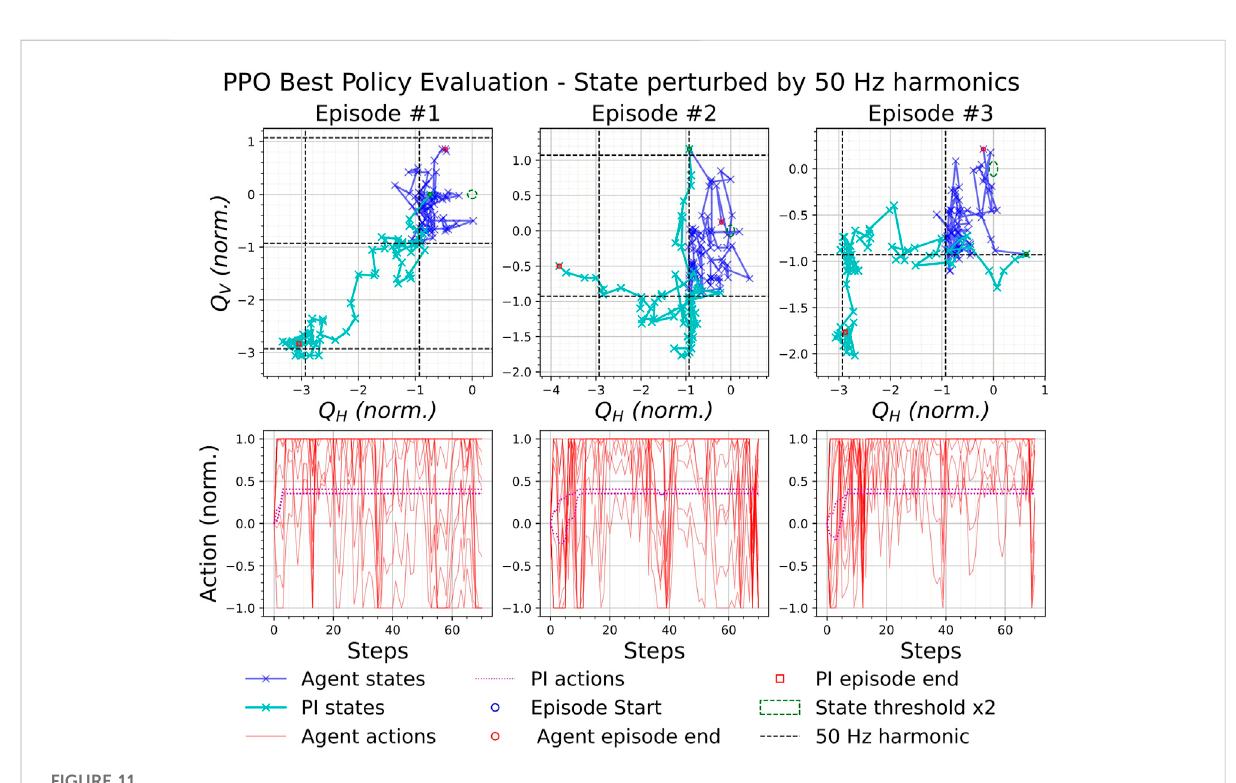
FIGURE 11 Effect of inaccurate tune estimation on the best PPO